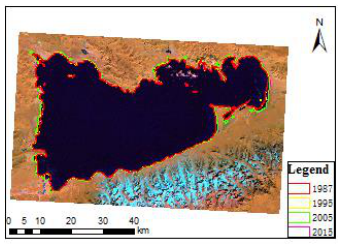
Figure 14. Nam Co area changes from 1995 to 2015